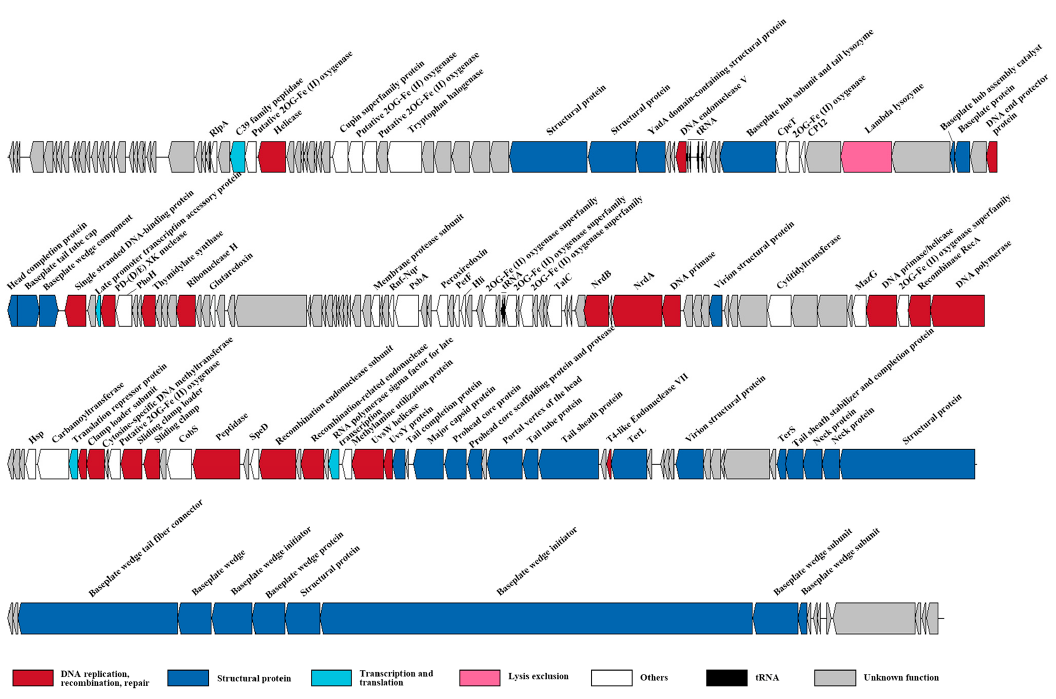
Figure 2. The genome map of cyanophage S-SZBM1. Genes within different functional categories are indicated by colors noted below. Viruses 2022 , 14 , x FOR PEER REVIEW